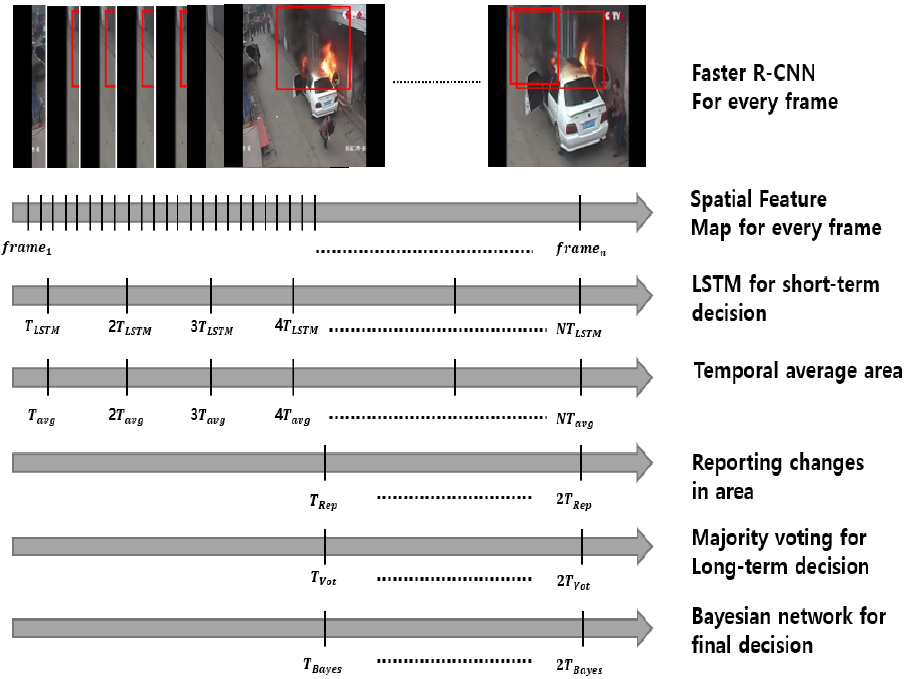
Figure 2. Timing diagram of fire detection [26].